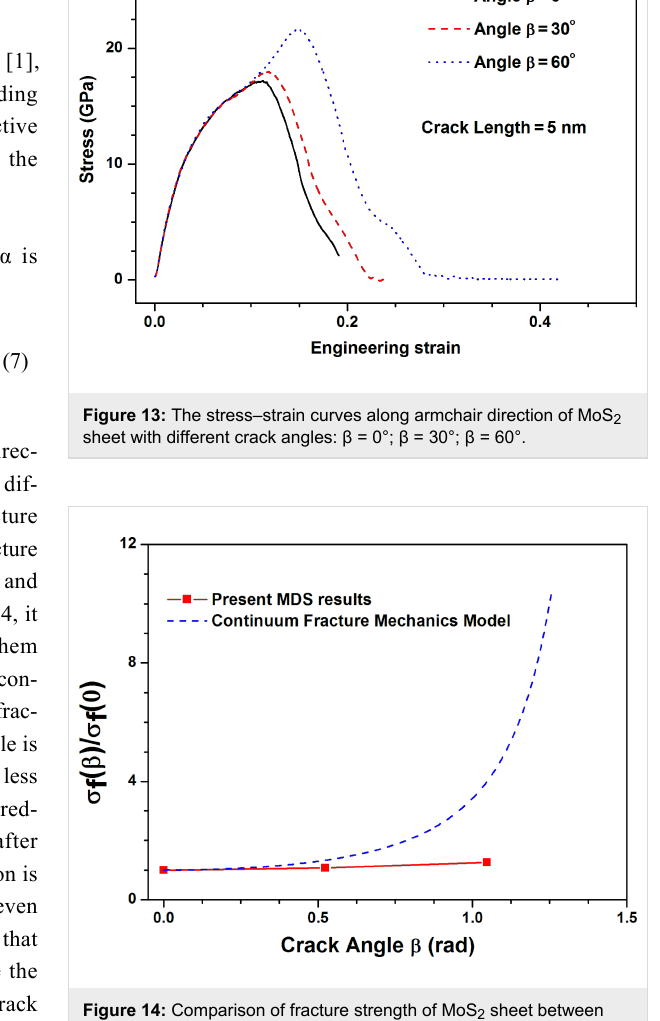
Figure 14: Comparison of fracture strength of MoS 2 sheet between MDS results and continuum fracture mechanics model versus different crack